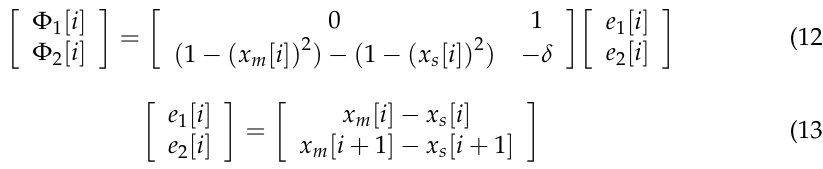
Figure 3. Dynamic error scatter diagrams for different risk levels: ( a ) normal condition (Nor), ( b ) lower PAD (LPAD), and ( c ) higher PAD (HPAD). 2.3. Time-Domain Analysis with Reflection Index In the time-domain analysis shown in Figure 4a, a PPG waveform characteristically consists of a systolic peak, dicrotic notch, and diastolic peak. The PPG waveform can be used to assess CVDs and arterial compliance. For arterial compliance assessment, SI and RI [8,12–14] are two arterial stiffness measurement methods: SI is used to measure large arterial stiffness, whereas RI is used to measure small to medium-sized arterial stiffness, such as extreme PADs. Both of them are significantly correlated with age, HR, systolic blood pressure, and diastolic blood pressure [8,12–14]. The RI index can be estimated as follows: %100 12  HH RI (15) where H 1 is the amplitude of the early systolic peak and H 2 is the amplitude of the dias- tolic peak. In this study, the RI is used to assess the stiffness in the extremity arteries of the upper or lower limbs. For 40 subjects (i.e., 11 Nor, 11 LPADs, and 18 HPADs), with the correlation analysis using the quantizer shown in Figure 4b and a linear regression method (i.e., least squares estimation) [21,37], the comprehensive dynamic error, Φ, has a positive correlation with the RI% (RI = −4.649 Φ + 94.939, R 2 = 0.6694). Through prelimi- nary verification, different chaotic feature maps can be used to extract the comprehen- sive error scales to predict the extreme arterial stiffness levels. In the subsequent section, with the chaotic feature map-based training patterns, the 1D CNN will be established as a classifier for automatically screening the PAD risk levels.